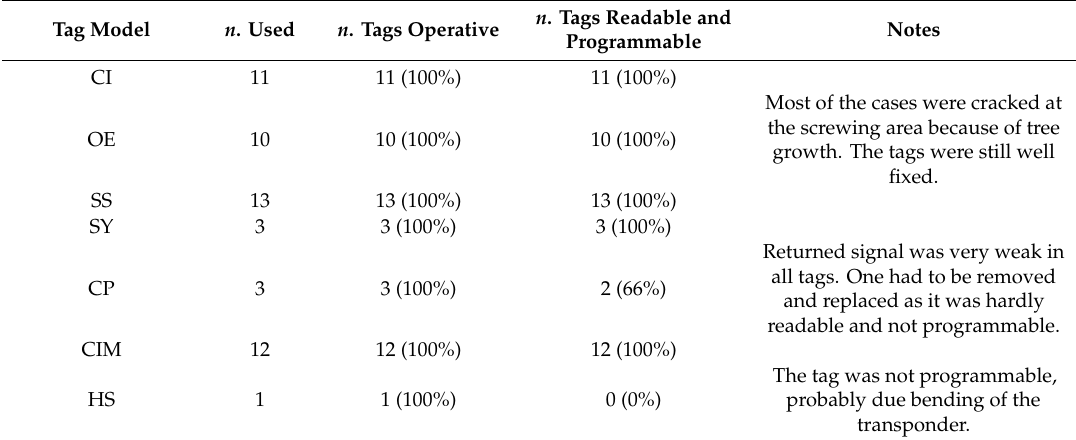
Table 3. Operative conditions of tags after 1 year permanent installation in forest.